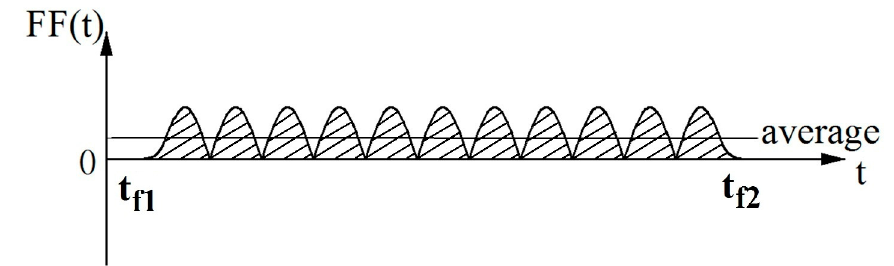
Figure 8. Friction force intensity, t f 1 : the time when the friction measuring disc starts rotating; t f2 : the time when the friction measuring disc has just stopped rotating. t f2 : the time when the friction measuring disc has just stopped